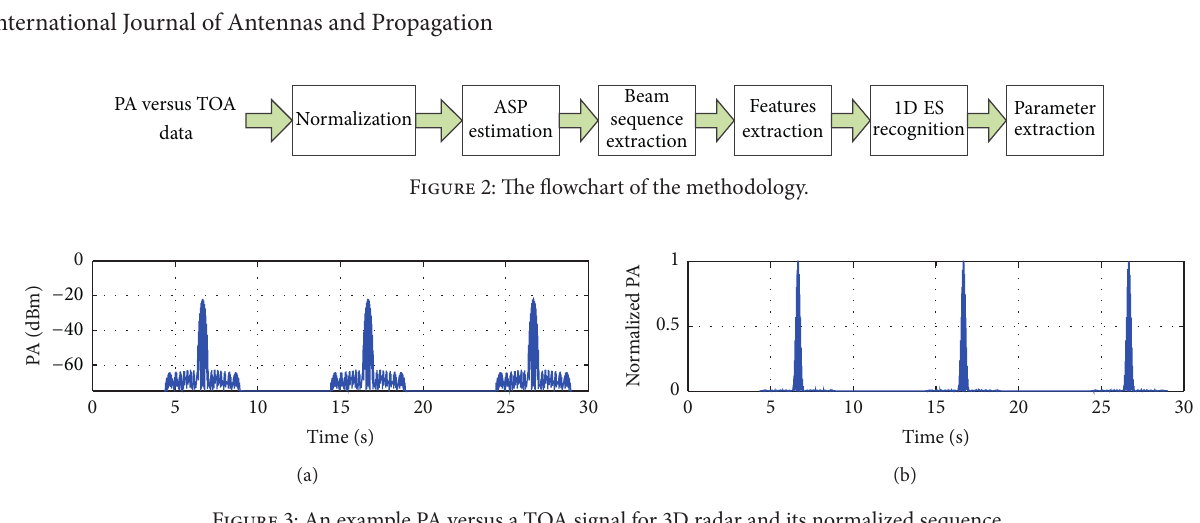
Figure 3: An example PA versus a TOA signal for 3D radar and its normalized